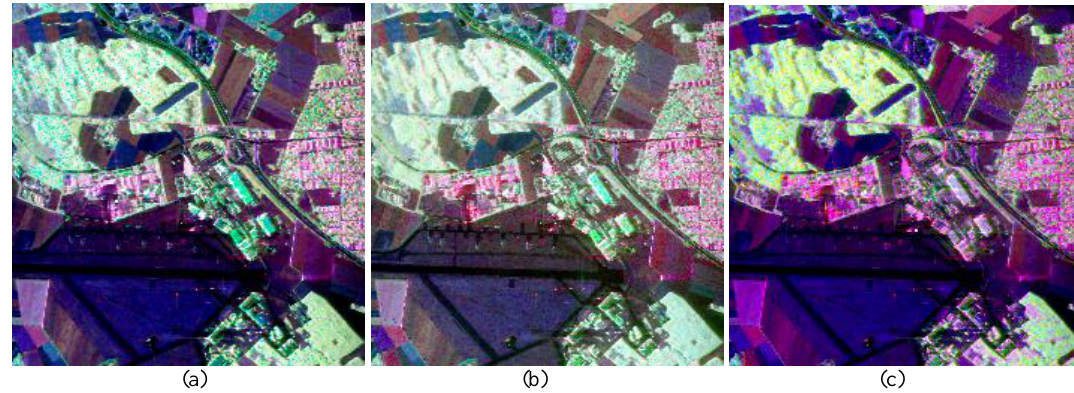
Figure2.. Decomposition results. Processed by (a) Freeman, (b)Yamaguchi, (c) the proposed methods